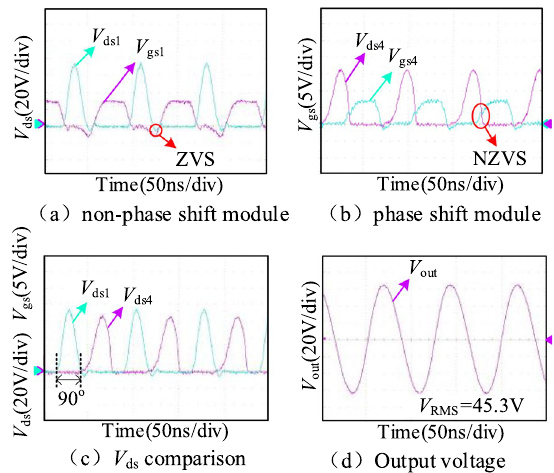
Fig. 13 Working waveforms with phase shift of 90°